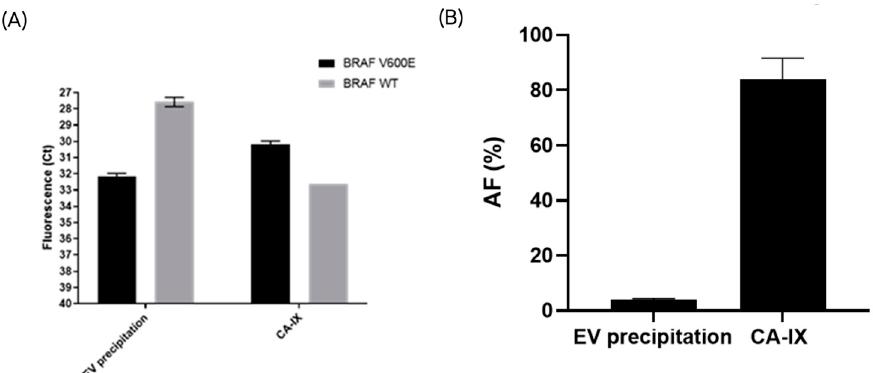
Figure 6. The CA-IX-based immune-isolation of sEVs from metastatic melanoma liquid biopsies improved the detection of the BRAFV600E mutation compared to the generic EV precipitation method. Data are expressed as the threshold cycle (Ct) values and plotted on an inverted Y scale ( A ). Mutant BRAFV600 allelic frequency (%) was calculated for the two isolation methods. A statistically signi fi cant di ff erence was found between the two methods ( p -value = 0.04) ( B ).